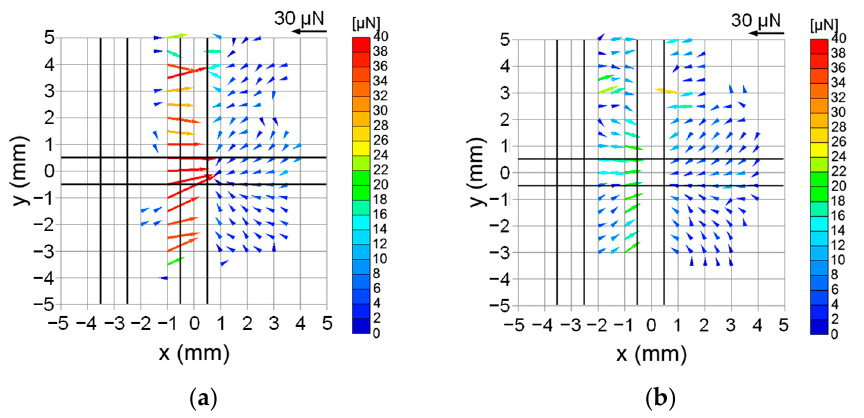
Figure 14. Comparison of experimentally obtained electrostatic forces between the cases where the upper electrode of the initial point is grounded and floating: ( a ) The case of grounded; ( b ) The case of